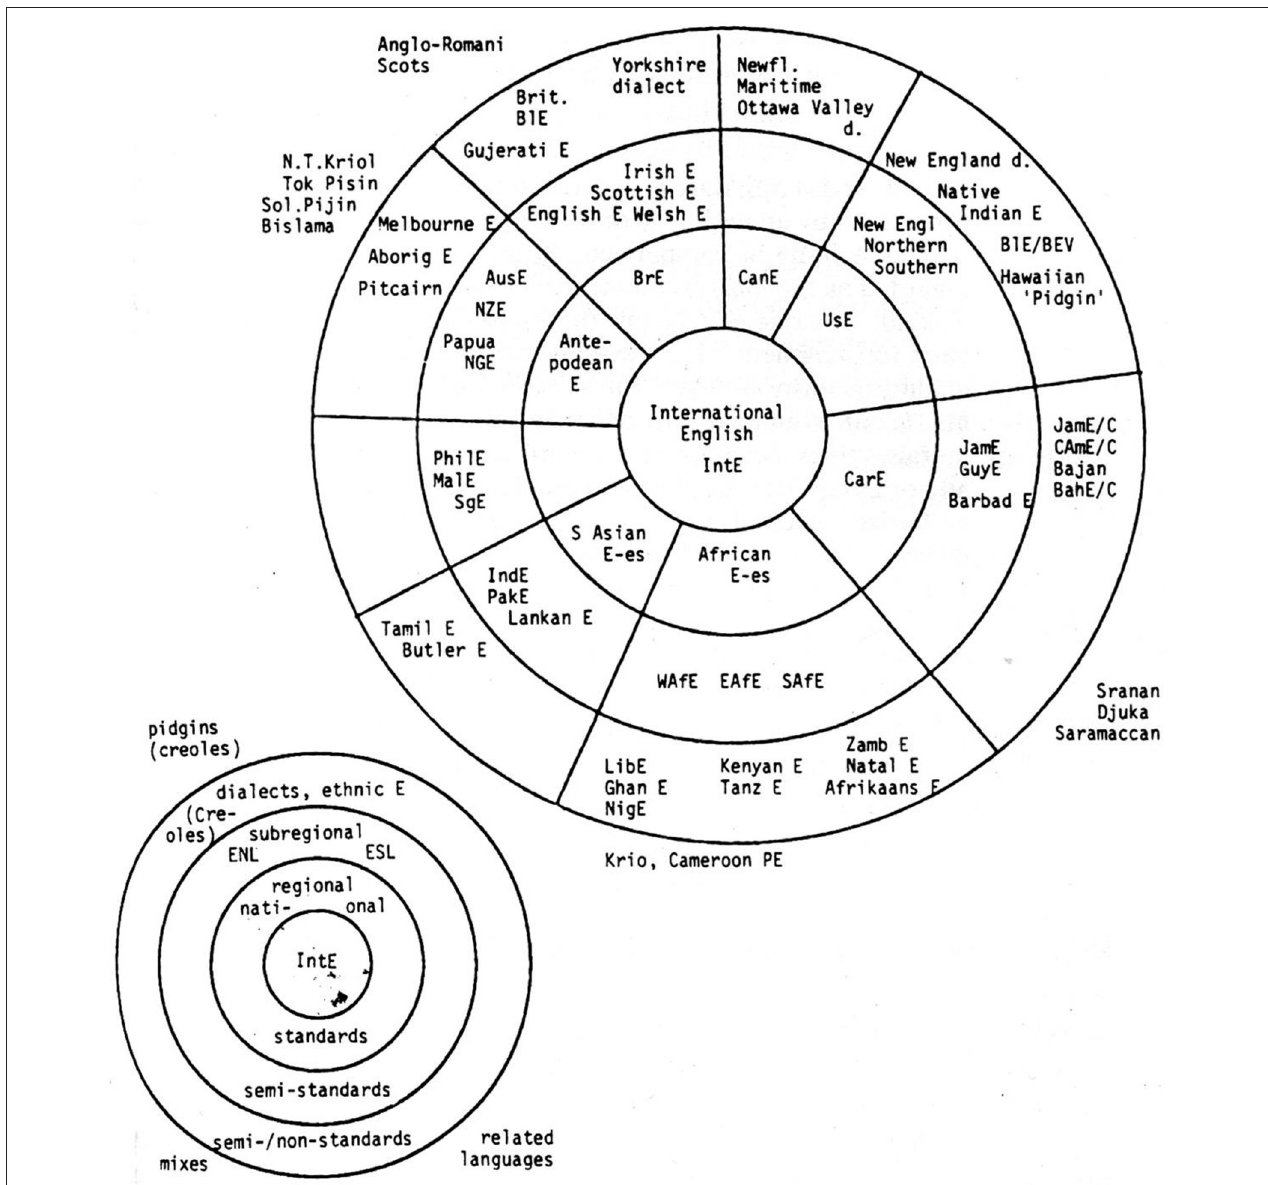
FIGURE 3 | Görlach’s “Circle of International English” (from Görlach,